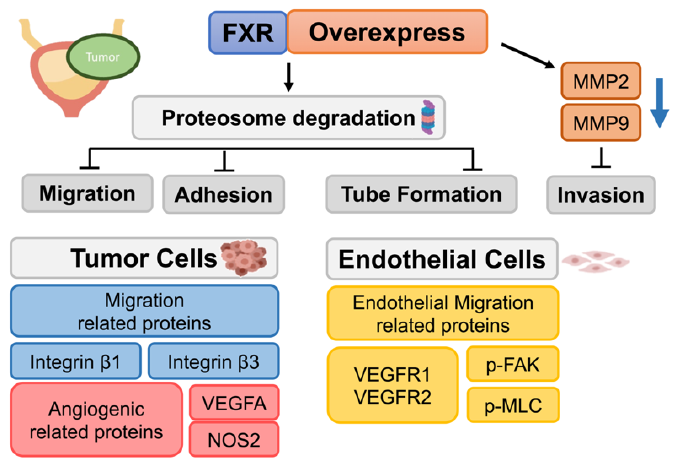
Figure 11. Scheme of FXR overexpression downregulated bladder cancer cell migration, adhesion, and tube formation.